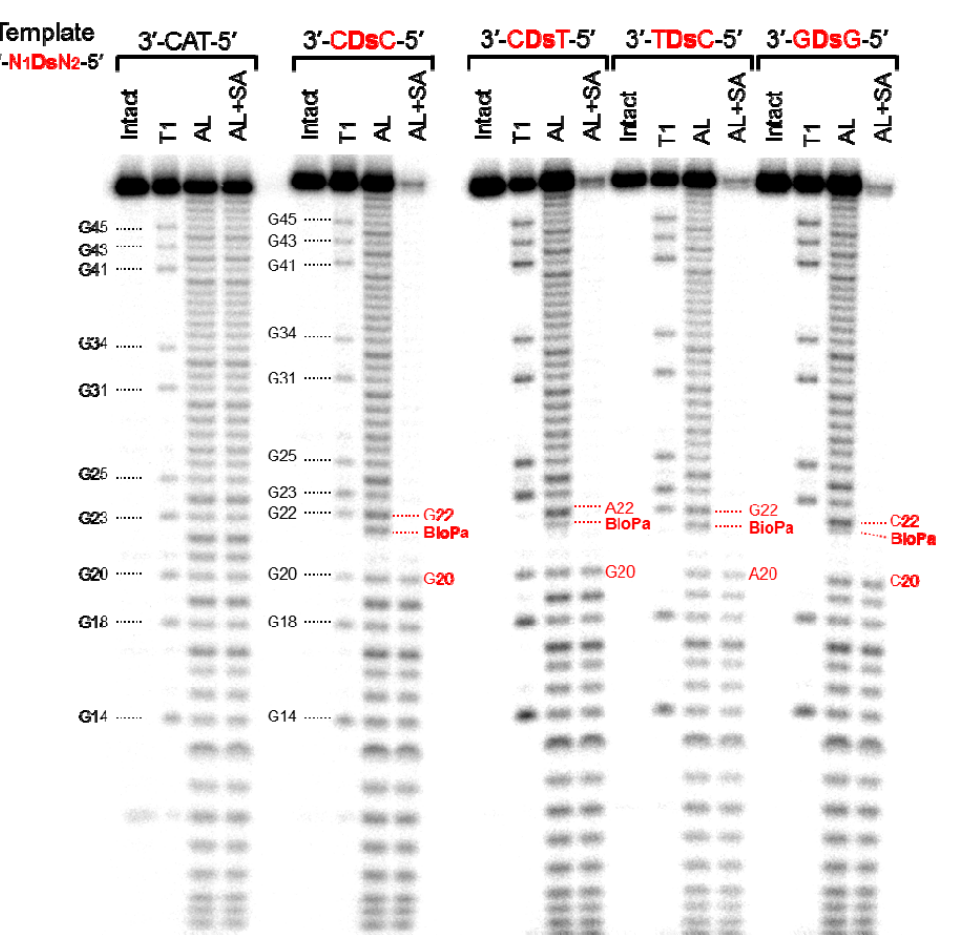
Figure 4. Sequence analysis of the 48-mer transcripts containing Biotin- Pa or U at position 21. The 5 ′ 32 P-labeled transcripts were partially digested with either RNase T1 (T1) or with alkali (AL). A portion of the partially alkali-digested transcripts was treated with streptavidin magnetic beads, to capture the RNA fragments containing Biotin- Pa (AL+SA). Each digested fragment was analyzed on a 10% polyacrylamide gel containing 7 M